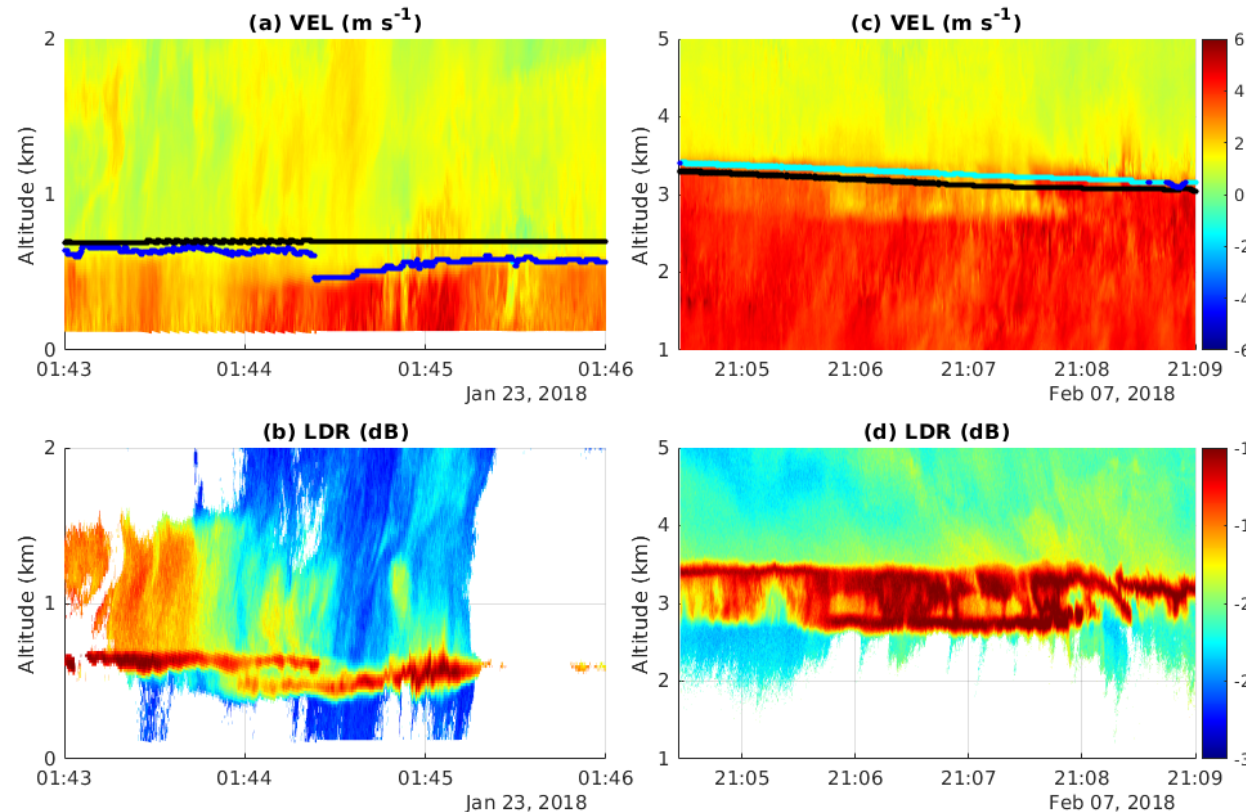
Figure 7. Radial velocity and melting layer data ( a , c ) and linear depolarization ratio ( b , d ) for two cases (left panels and right panels) where a split melting layer was observed. Colors in ( a , c ) as in Figure 5. Times are in UTC.